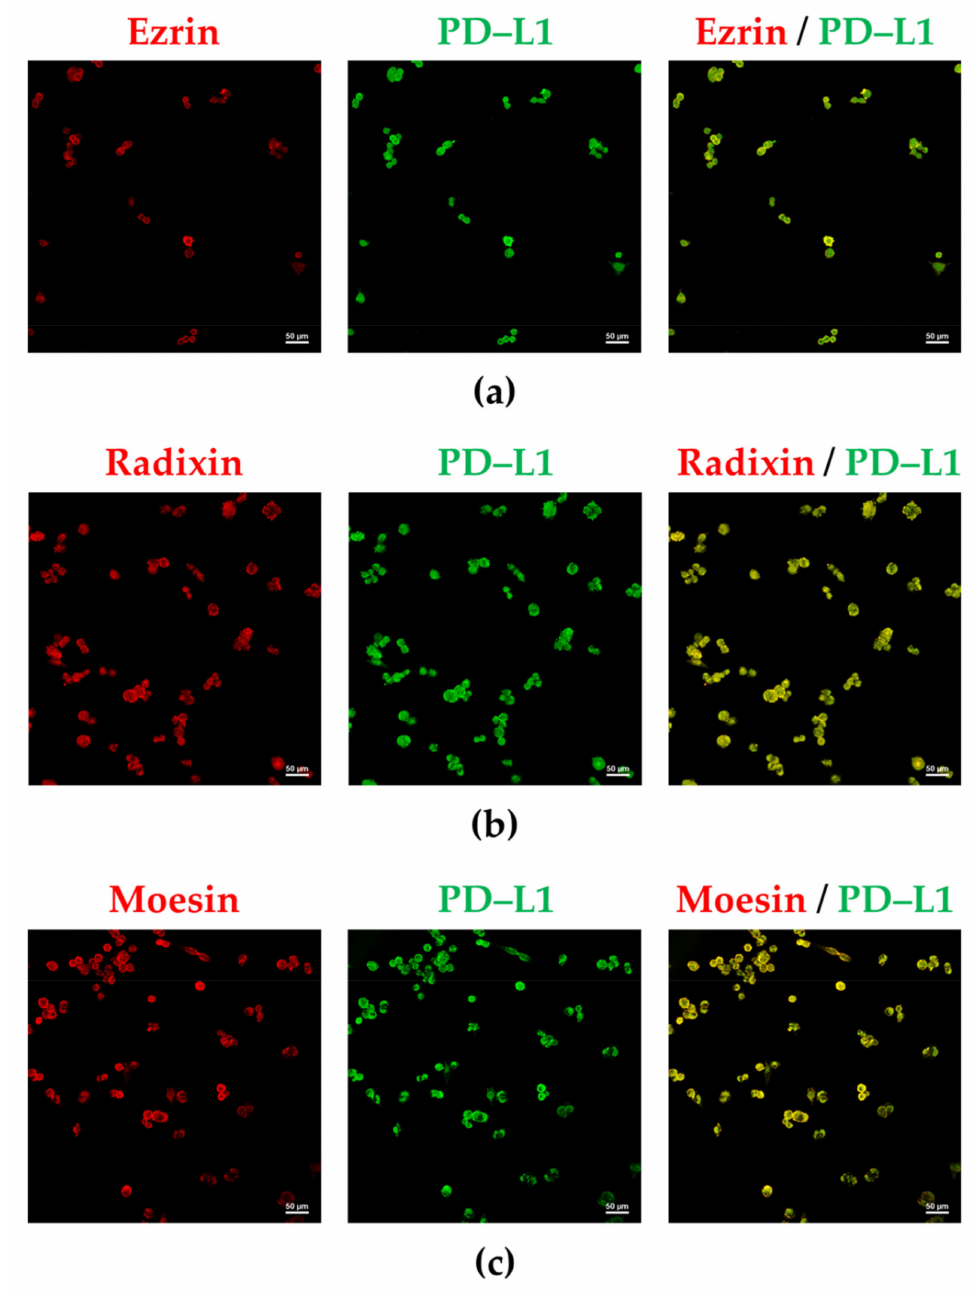
Figure 3. Double immunofluorescence staining for programmed death ligand–1, ezrin, radixin, and moesin in A2780 cells. Left panels: Alexa Fluor 594 (red)-labeled ( a ) ezrin, ( b ) radixin, and ( c ) moesin; middle panels: Alexa Fluor 488 (green)-labeled programmed death ligand–1 (PD–L1); right panels: merged fluorescence images. Scale bars: 50 µ m. All images are representative of at least three independent